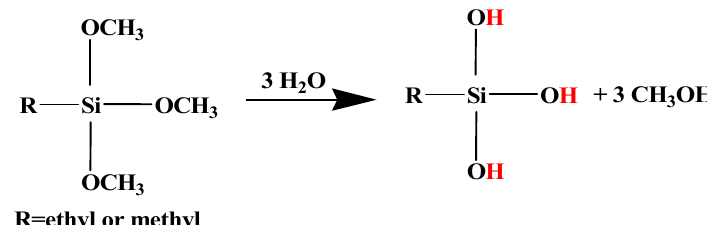
Figure 2. Representation of the general hydrolysis mechanism of silanes. Adapted from [30].